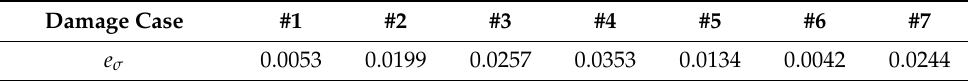
Table 6. Reconstructed value errors of single-defect reconstructions in experiment.